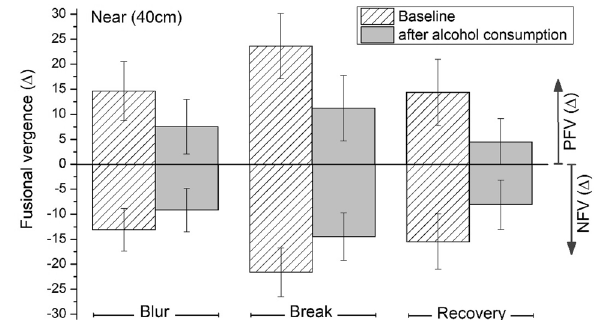
Figure 3. Mean values for the horizontal fusional vergences at near distance at baseline and after alcohol consumption (BrAC = 0.40 mg/l). Blur, break, and recovery are shown for the negative fusional vergences (NFV) and positive fusional vergences (PFV). Error bars show standard deviations.